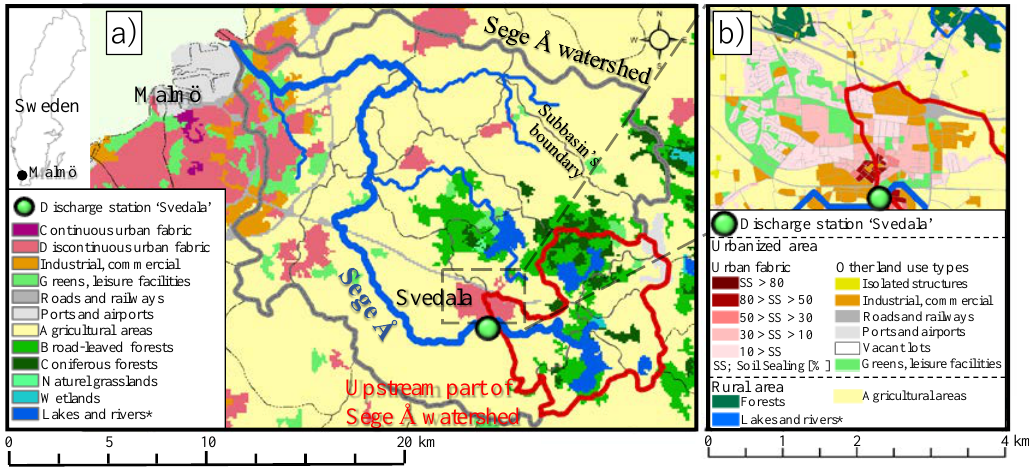
Figure 1. ( a ) The upstream part of Sege Å river basin (red line) and location of the discharge station outside Svedala town (green dot). The land-use is from EEA CORINE. ( b ) A blow-up of Svedala town with land-use from EEA Urban Atlas. *Lakes and rivers were obtained from the Swedish Water Archive (SVAR).